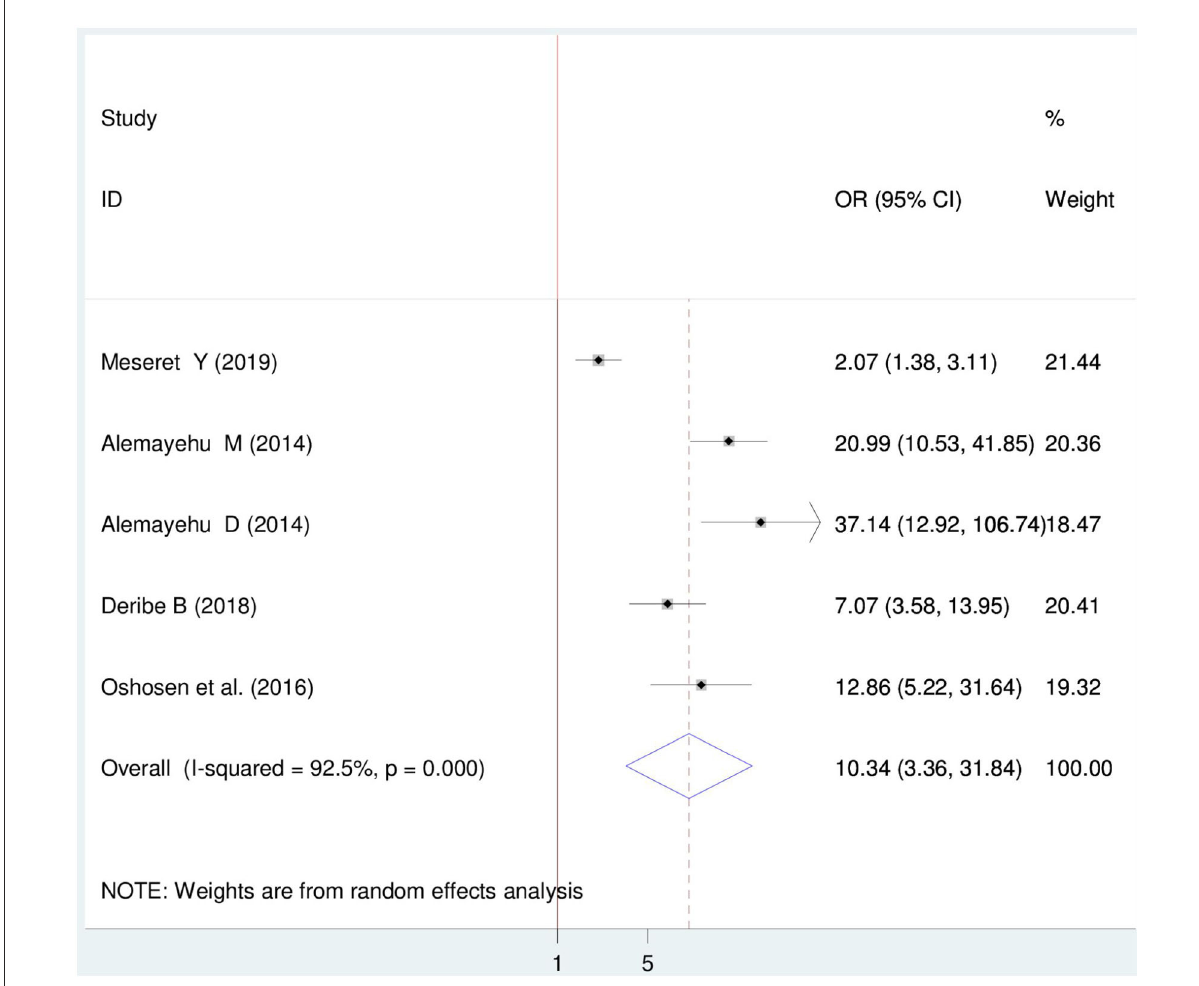
FIGURE6 Forest plot of association between HIV sero-status disclosure and knowing partner HIV status among women in East Africa,